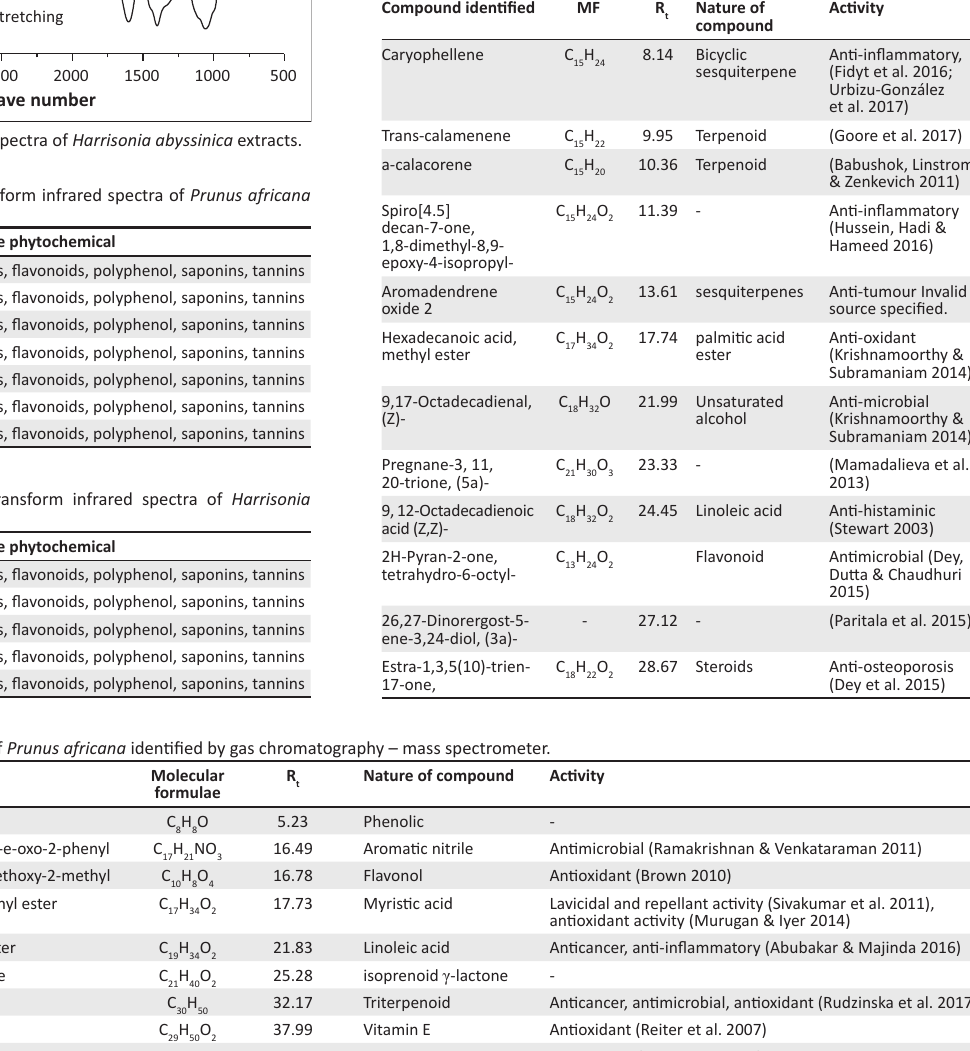
TABLE 5: Phytochemical compounds of Harrisonia abyssinica identified by gas chromatography – mass spectrometer.